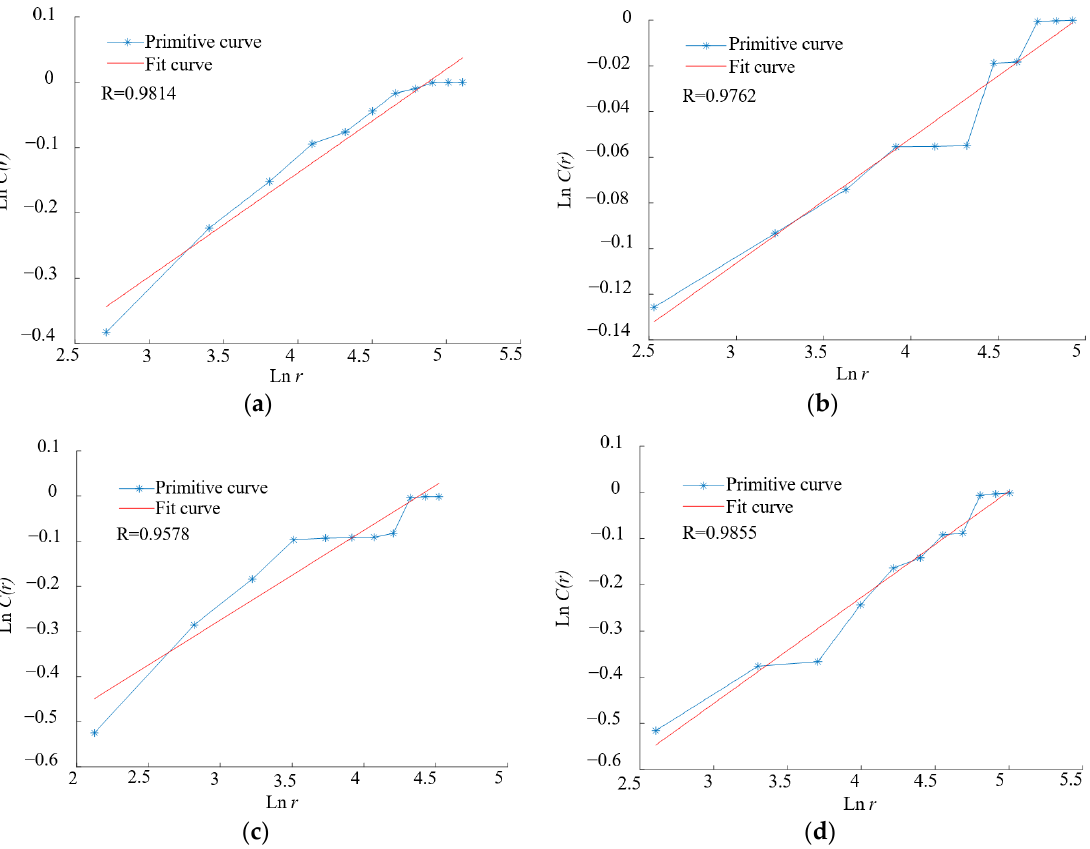
Figure 10. Double logarithmic relationship of AE energy of the limestone. ( a ) The limestone without a rockburst tendency; ( b ) the limestone with a weak rockburst tendency; ( c ) the limestone with a medium rockburst tendency; and ( d ) the limestone with a strong rockburst tendency.